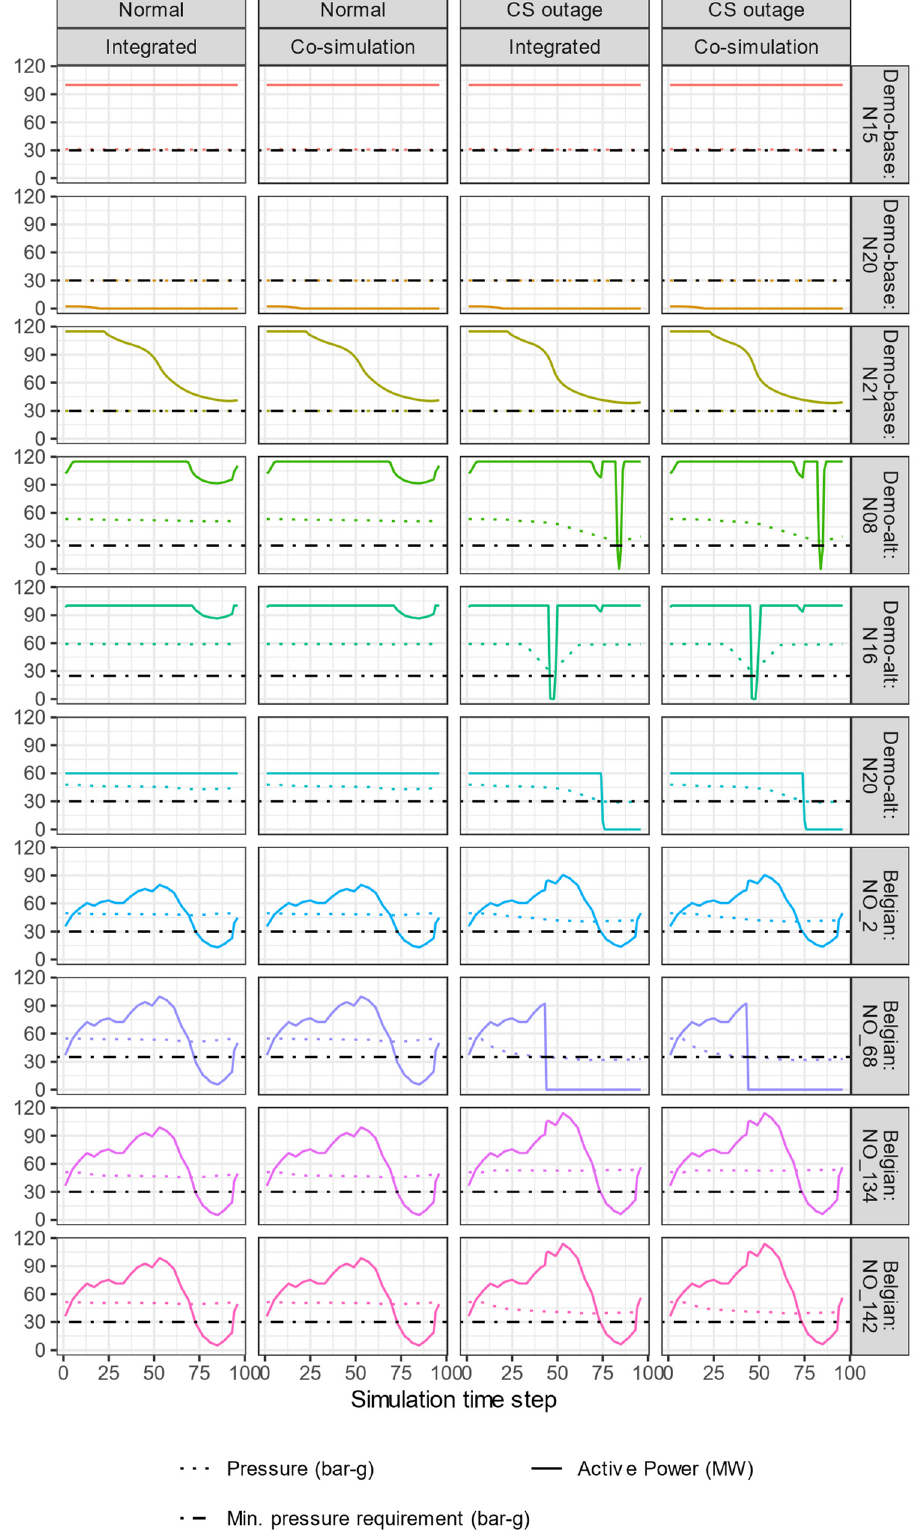
Figure 10. Depiction of gas offtake pressure (bar-g) and active power generation (MW) for coupled nodes and gas-fired power plants of each network. Black dashed lines in the pressure panels indicate the minimum delivery pressure required at that node for the gas-fired power plant to operate.